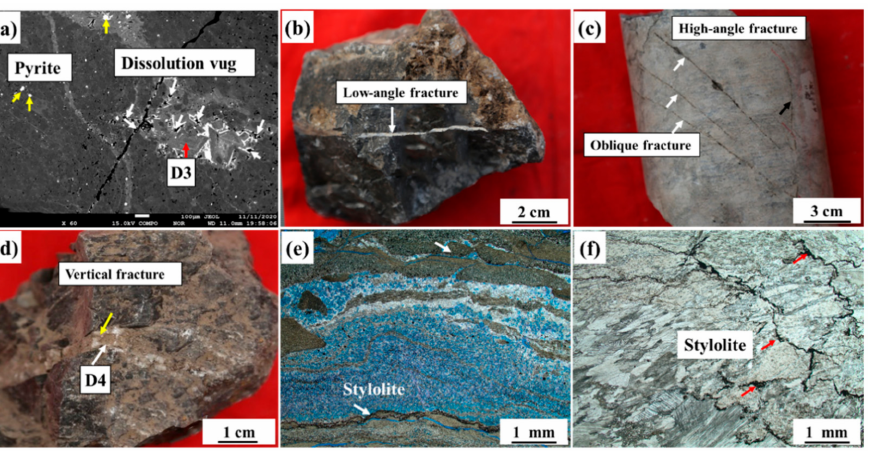
Figure 9. Diagenesis types of dolomite reservoirs in the Dongying Depression, Bohai Bay Basin. ( a ) Microcrystalline dolomite; hydrothermal dissolution vugs. The pyrite filled in the vugs (yellow arrow), and medium-to-coarse-crystalline dolomite cement was dissolved and formed intragranular dissolution pores, Well Bg22 2246.89 m, Ordovician formation, backscattered image; ( b ) microcrys- talline dolomite; low-angle fracture, filled with calcite cements; Well Bg26 2515.2 m, Yeli-Liangjiashan formation, core; ( c ) oblique fractures (white arrow) formed before high-angle fractures (black arrow), Well Bg26 2803.7 m, Zhangxia formation, core; ( d ) microcrystalline dolomite; vertical fracture (yellow arrow), filled with saddle dolomite; Well Bg22 2236.4 m, Ordovician formation, core; ( e ) the stylolite (white arrow) was formed by compaction and pressure solution, and filled argillaceous